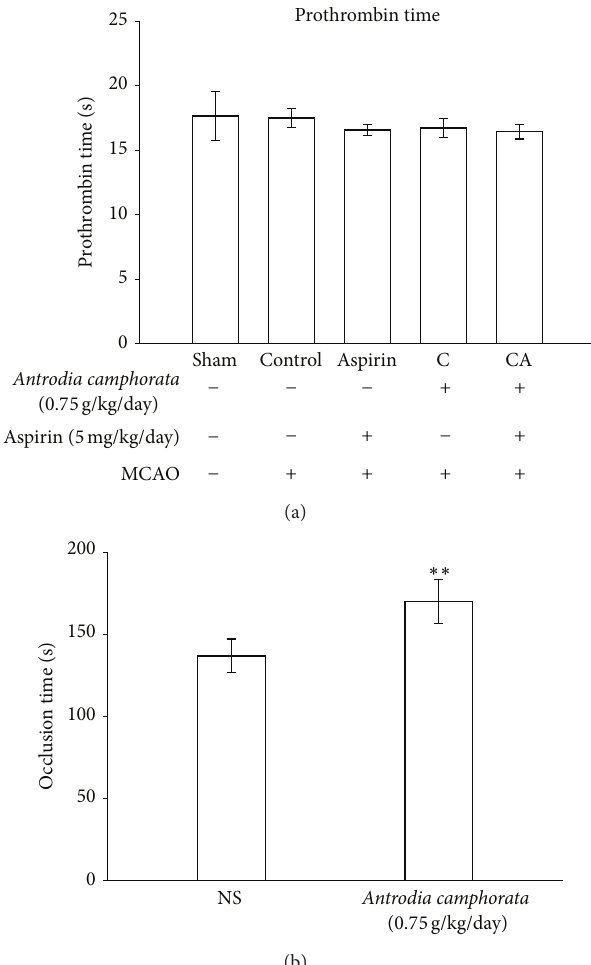
Figure 4: Effects of the extract of A. camphorata with aspirin on (a) prothrombin time (PT) and (b) occlusion time (OT) in thromboembolic stroke-induced rats. Data are presented as the means ± S.E.M. of three similar